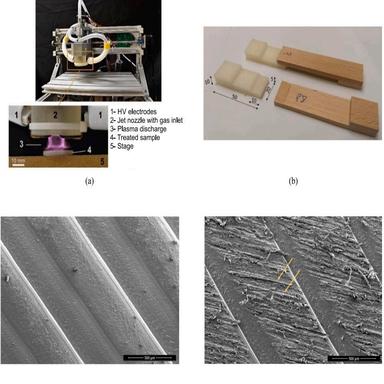
Schematics of different treatment techniques: (a) plasma device for the surface treatment, (b) specimens for bond shear strength, (c) non-sanded, non-treated, and (d) sanded, non-treated PLA parts .